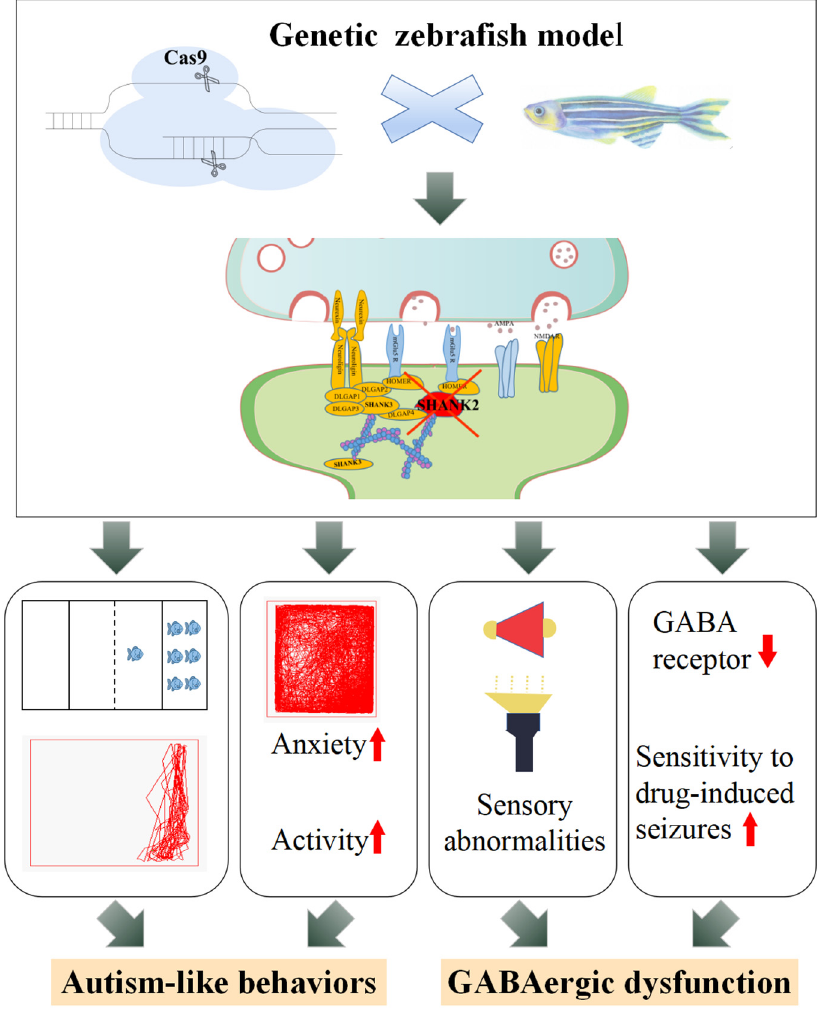
Figure 5. Potential mechanisms for regulation of GABAergic system in the shank2 -deficient zebrafish model.